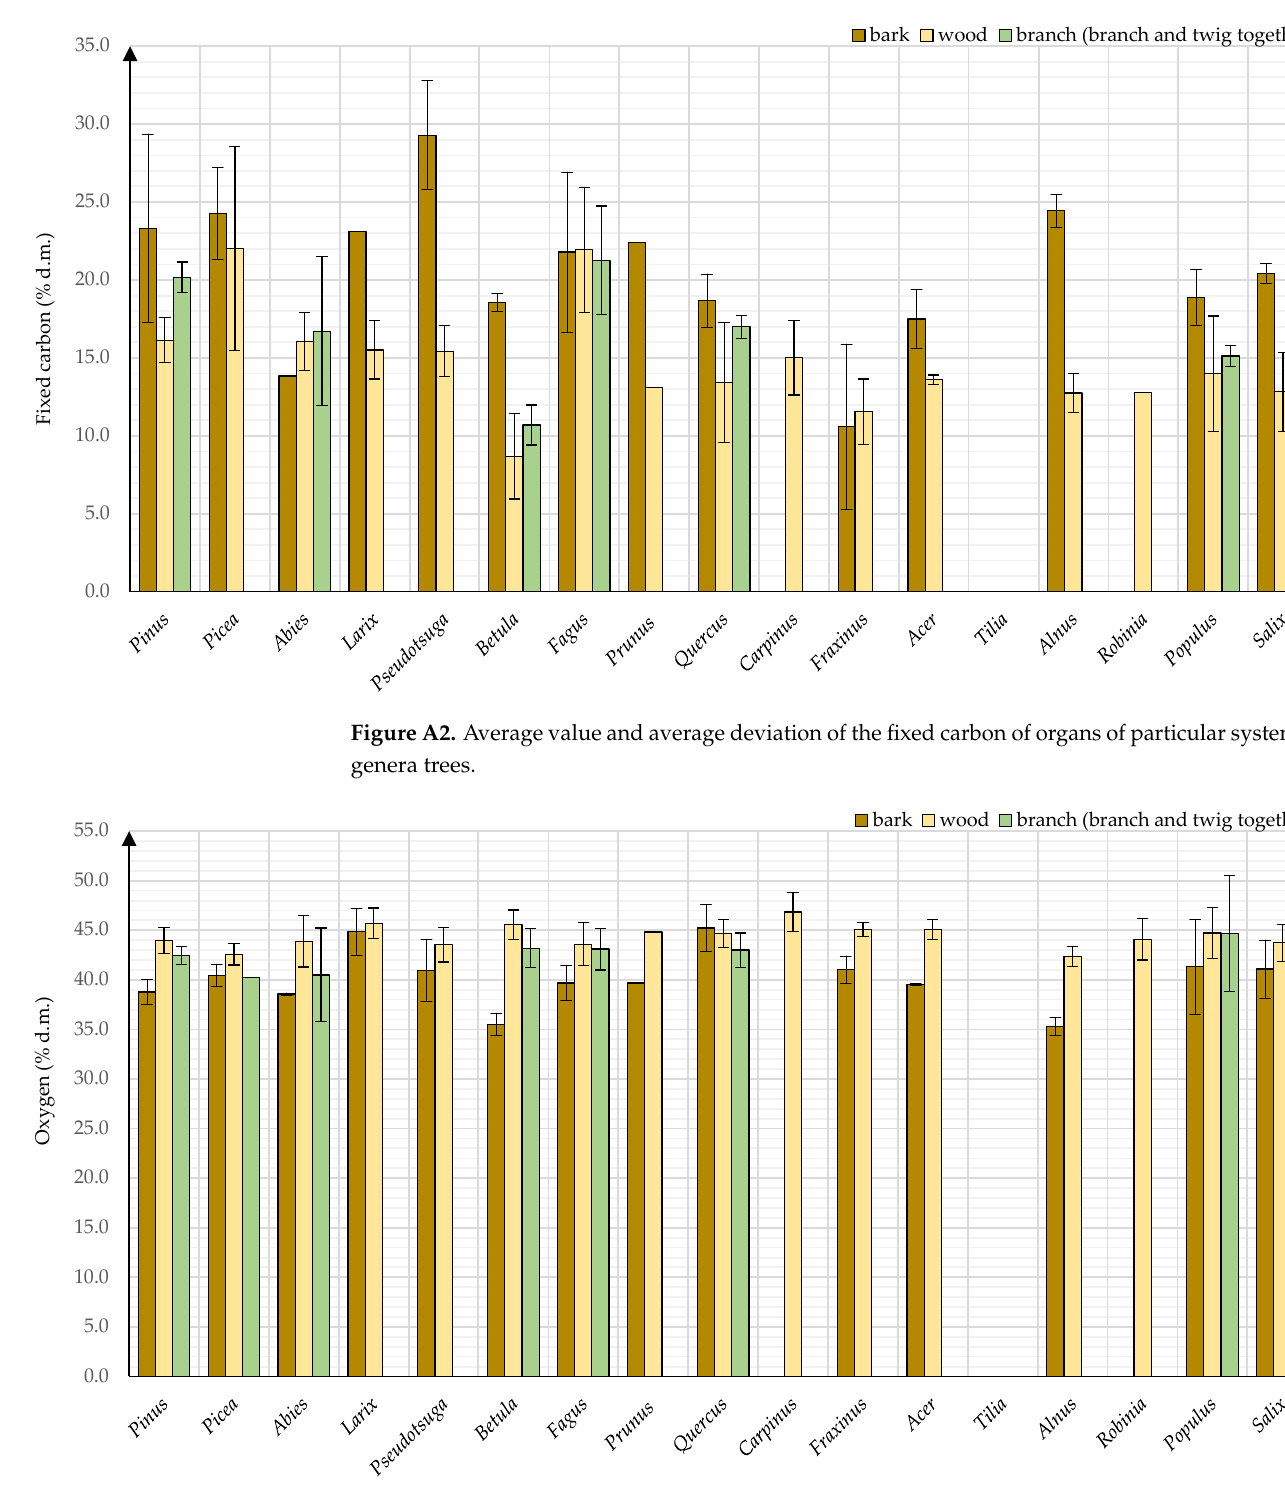
Figure A3. Average value and average deviation of the oxygen content of organs of particular systematic genera trees.